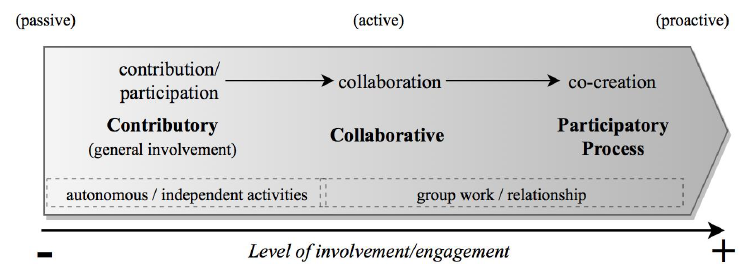
Figure 3. Volunteers’ Level of Involvement/Engagement and Related Modes of Organization.